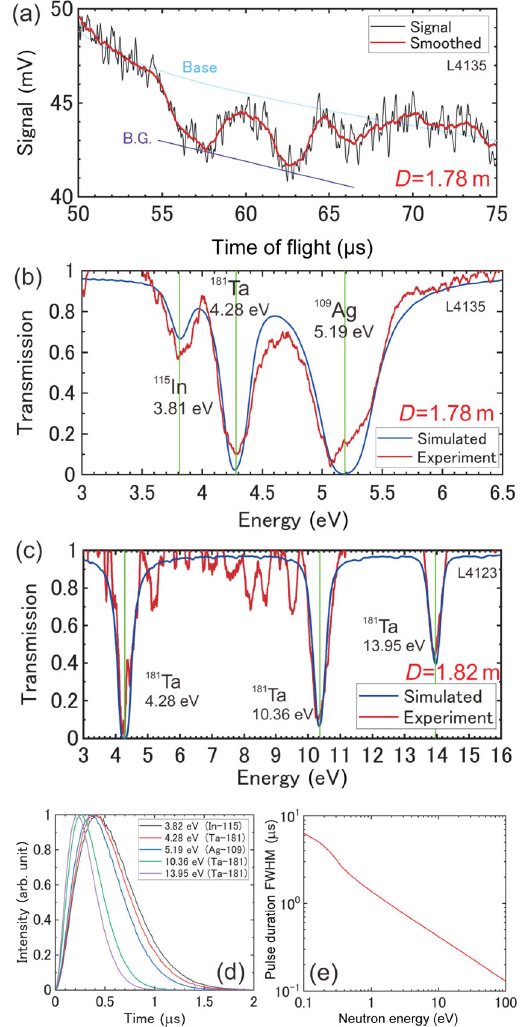
FIG. 6. (a) Signal measured by the TOF detector for the multilayer sample of 0.1-mm-thick Ag, Ta, and In. (b,c) Com- parisons between experimental and simulated transmittances as a function of the neutron energy for the Ag-Ta-In multilayer (b) and the 0.5-mm-thick Ta (c). (d,e) Pulse duration calculated at the exit of the moderator [Fig. 5(b)] for the neutrons having (cid:2) 1% energy